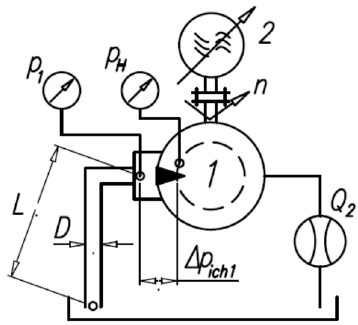
Figure 5. Diagram of the hydraulic circuit of the test stand for measuring the pressure drop in the internal channel of a hydraulic motor [16]: D and L —suction tube diameter and length, respectively, 1—tested motor, 2—electric motor controlled by a frequency converter, Q 2 —flow meter, n —rotational